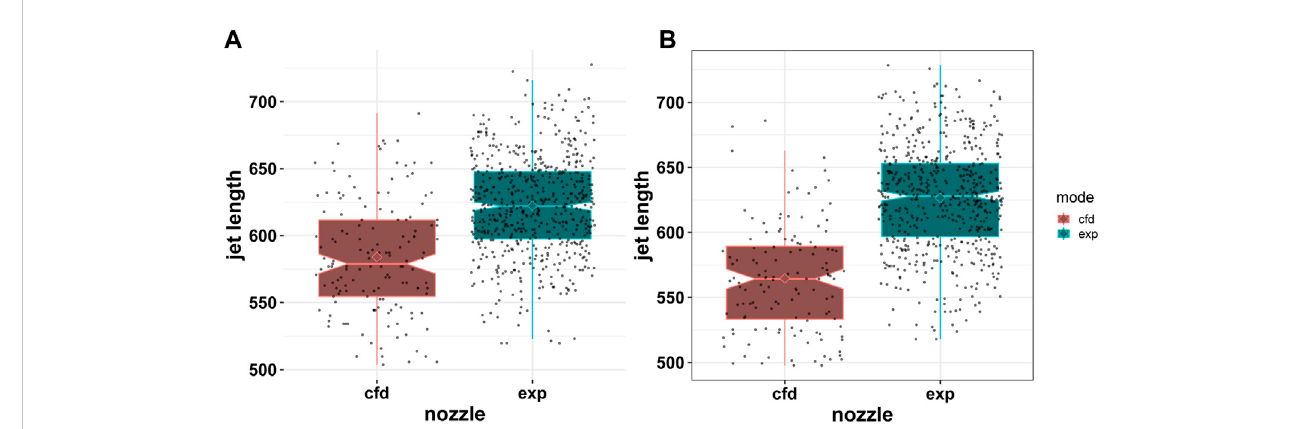
FIGURE 16 BoxplotofexperimentalandCFDresultsofthebell-shapednozzles (A) andboxplotofexperimentalandCFDresultsofthecone-shapednozzles (B) .The